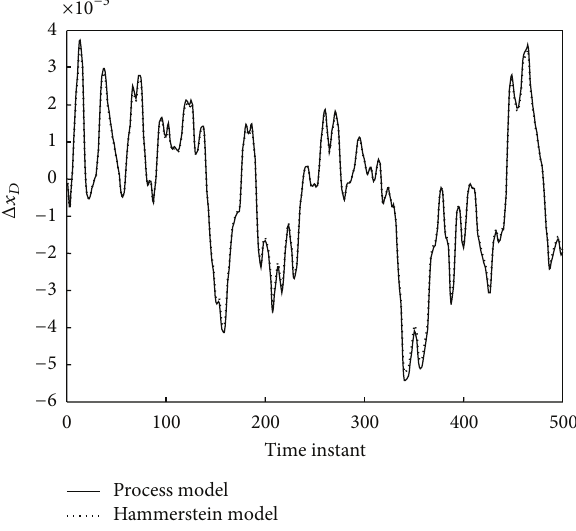
Figure 5: Comparison between the responses of first MISO Ham- merstein model and process model.